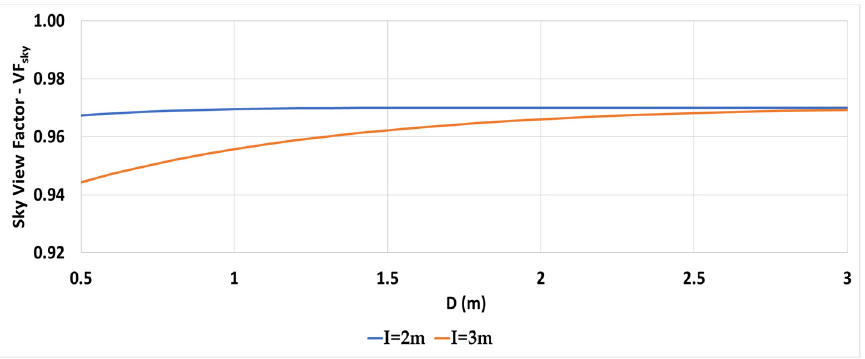
Figure 23. Variation of sky view factor of collector with distance from a convex roof-collector facing a convex roof.